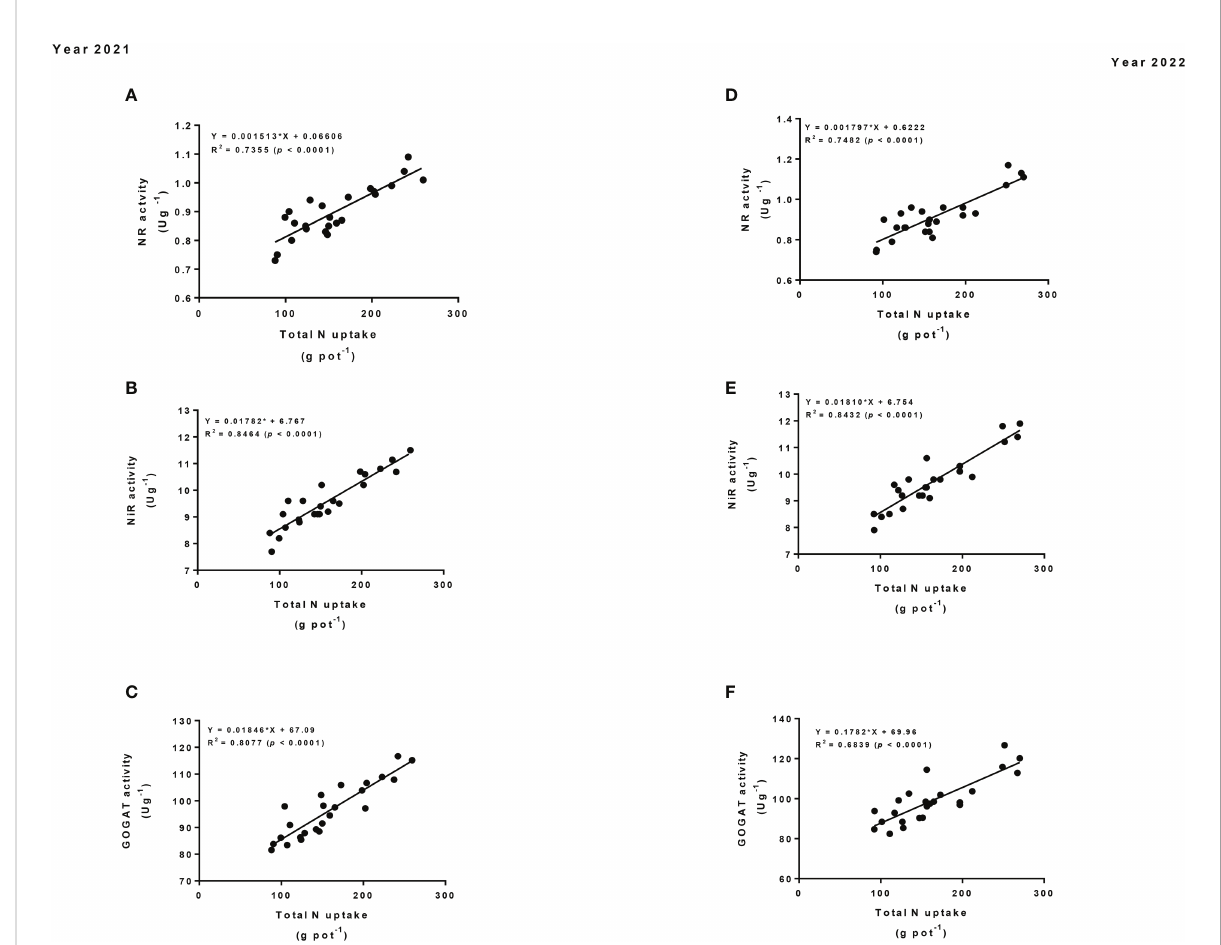
FIGURE 7 Regression analysis of the total N uptake with nitrogen assimilatory enzymes (i.e., NR (A, D) , NiR (B, E) , and GOGAT activity (C, F) ) of maize crop in 2021 and